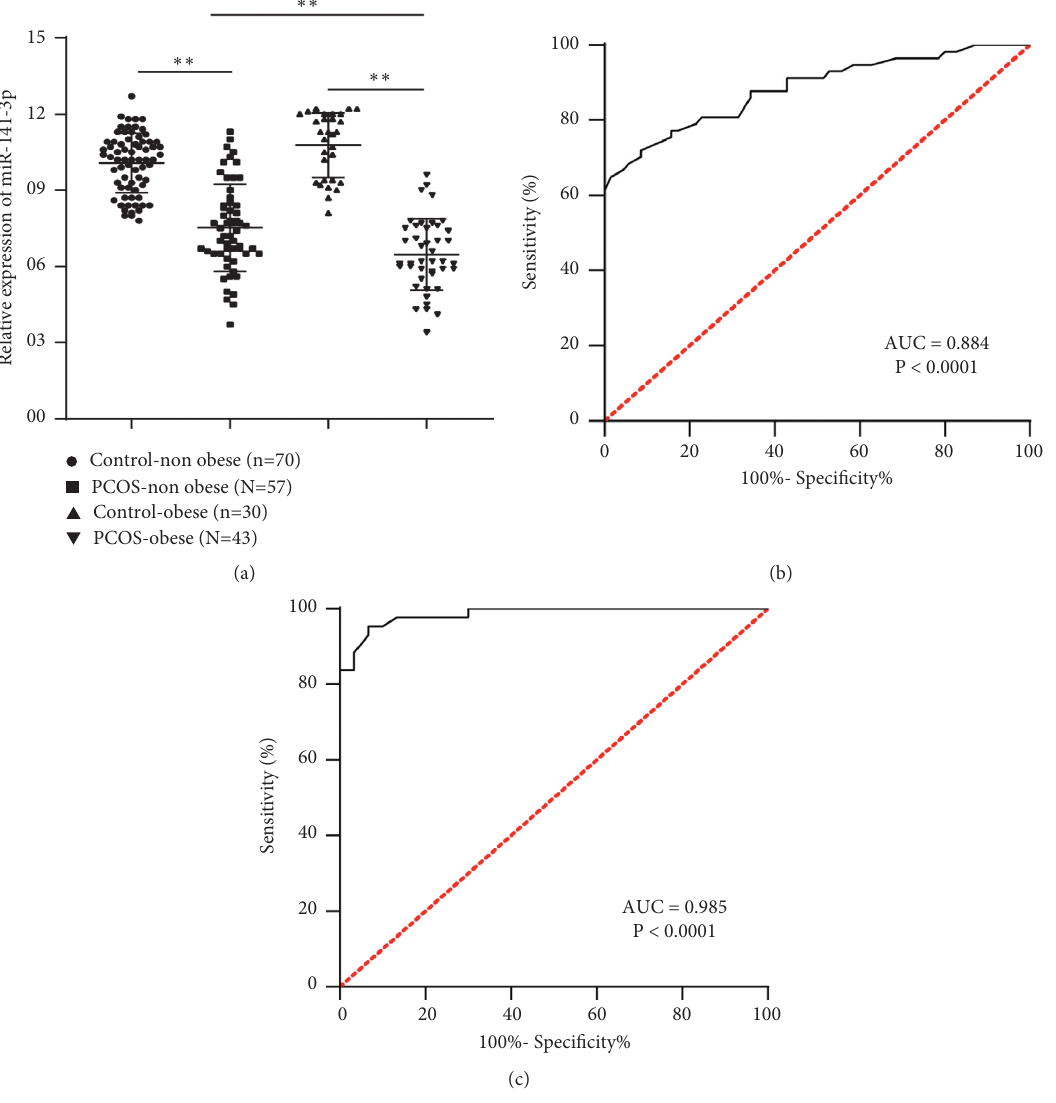
Figure 1: miR-141-3p was poorly expressed in serum of PCOS patients and possessed higher diagnostic efficiency. (a) miR-141-3p expression in serum of PCOS patients and healthy controls was detected by RT-qPCR; (b) diagnostic efficiency of miR-141-3p on PCOS- nonobese patients was analyzed using ROC curve; (c) diagnostic efficiency of miR-141-3p on PCOS-obese patients was analyzed using ROC curve. Data are expressed as mean ± standard deviation. Data in (a) were analyzed using one-way ANOVA, followed by Tukey’s multiple comparisons test. ∗∗ P < 0 .